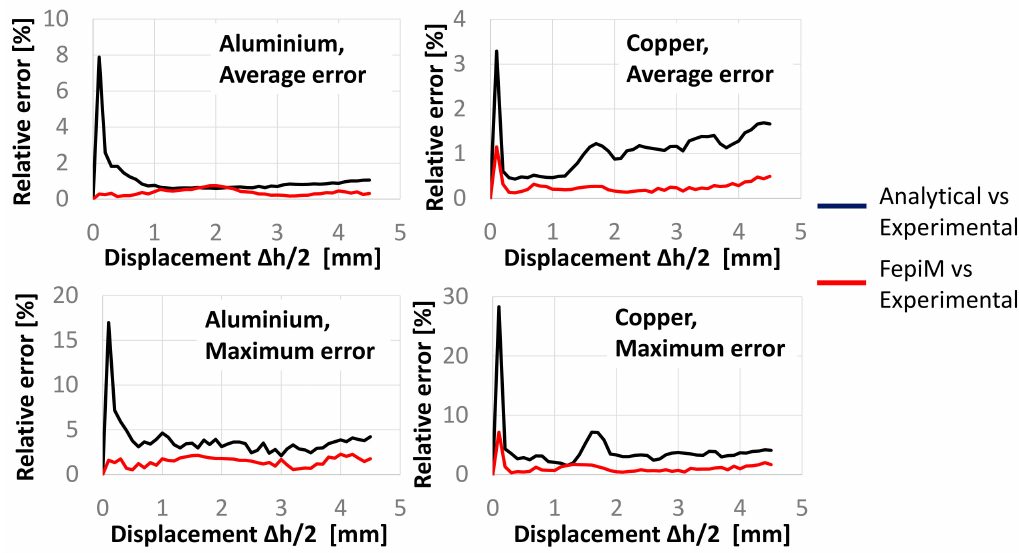
Figure 11. The average and maximum relative error for the complete flow curve field for aluminum and copper. In Figure 12, the average relative error ( ∆ ) is shown for each experimental condition in a heatmap. The error is calculated with respect to the experimental FD curve for both aluminum and copper. It is observed that the average error for the FepiM flow curves is always below 1% for all the conditions, whereas the error in the analytical flow curves is higher with a maximum average error of around 3%.